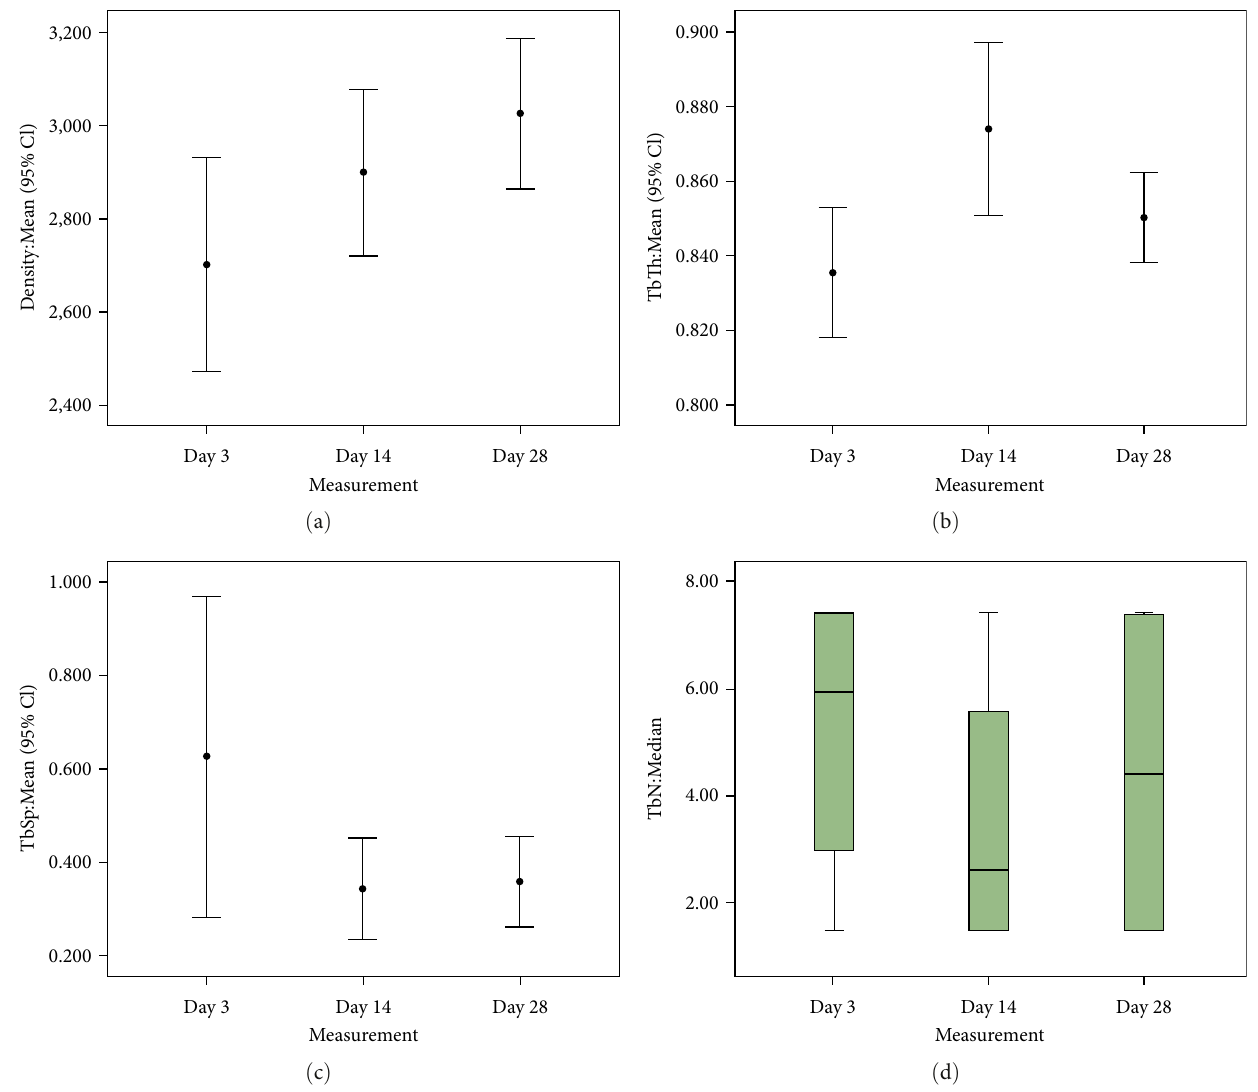
F IGURE 3: Comparison of (a) density, (b) Tb.Th., (c) Tb.Sp., and (d) Tb.N. values of osseointegration examination results from the three measurement times: (a) the density data are illustrated as mean +standard deviation; (b) the Tb.Th. data are illustrated as mean +standard deviation; (c) the Tb.Sp. data areere illustrated as mean +standard deviation; (d) the Tb.N. data are illustrated as median and